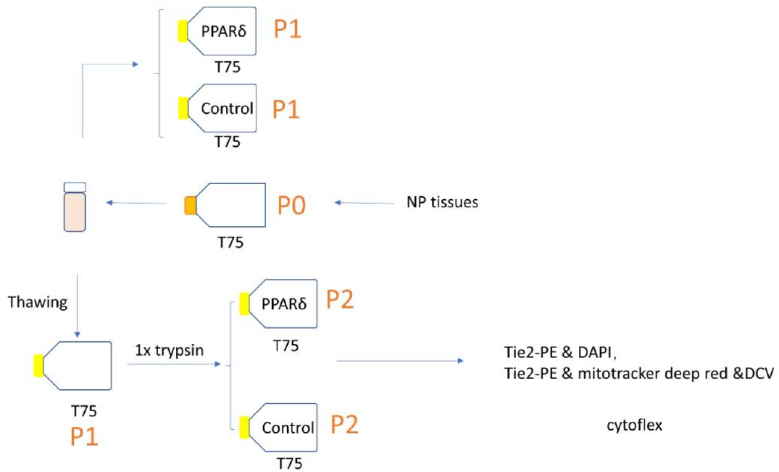
Figure 1. Schematic representation of the study experimental design; P =